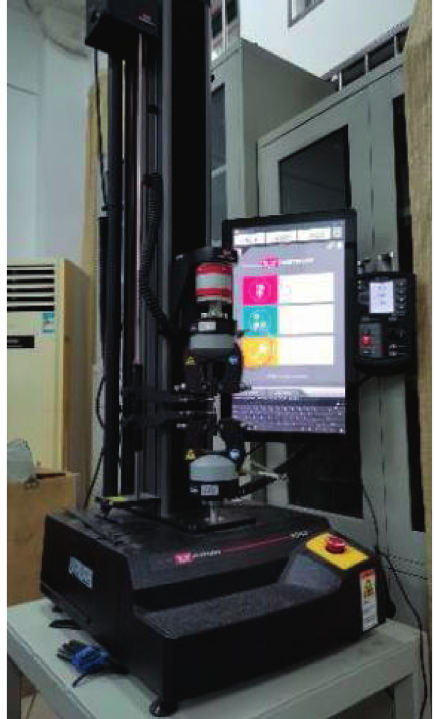
Figure 2: Quasistatic tensile experiment